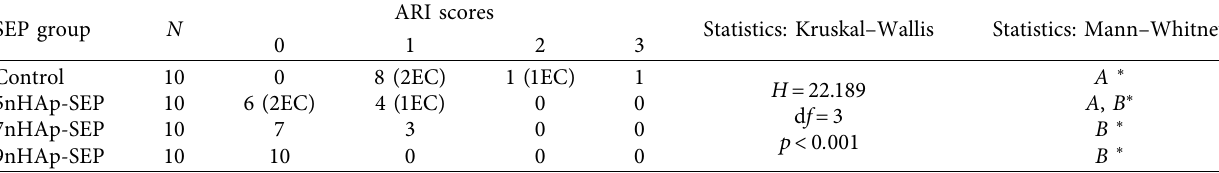
Table 3: Descriptive and inferential statistics of pilot adhesive remnant index (ARI) scores of bracket debonding at 24 h water storage. ARI scores SEP group N